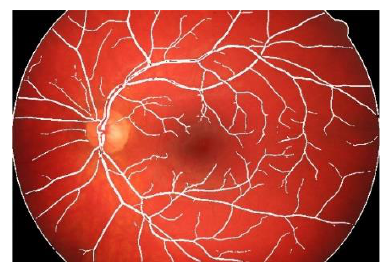
Figure 7.b Output image